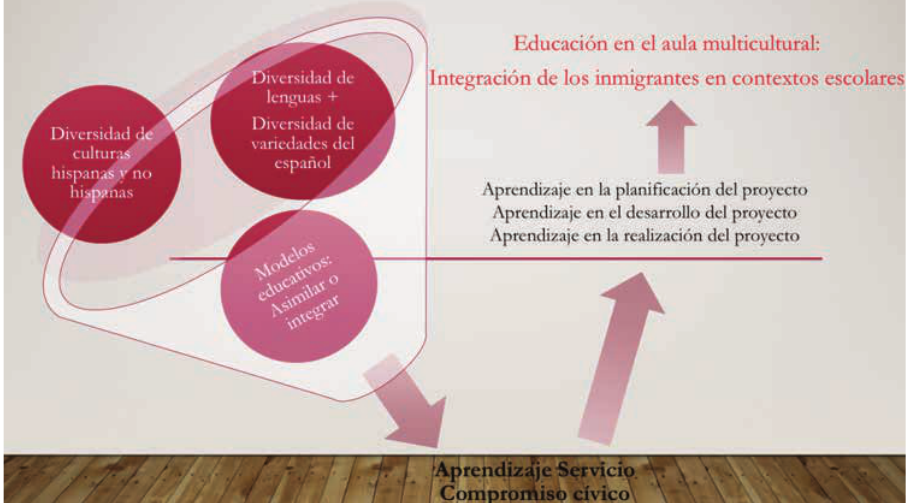
Figure 3: Education in Multicultural Classrooms Based on Service-Learning (SL)². Source: Fernández López and García Paredes (2018: